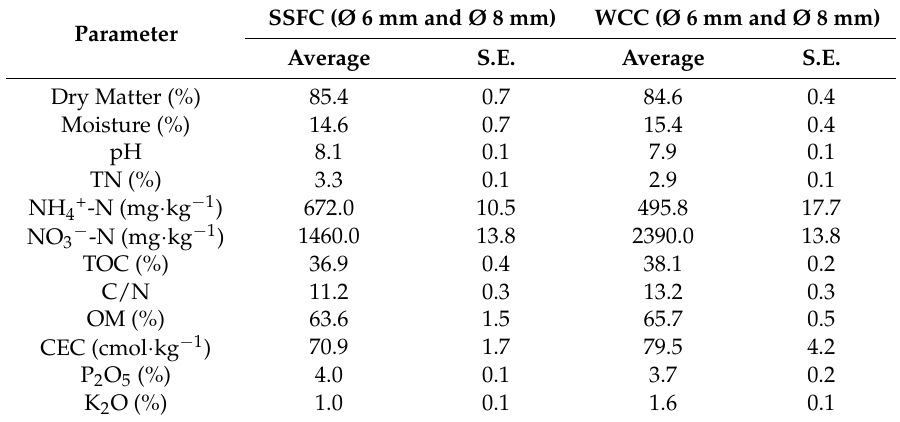
Table 1. Chemical characterization of the two pellet types investigated (SSFC: slurry solid fraction compost, WCC: Woodchip compost). Mean value and standard error (S.E.) of 3